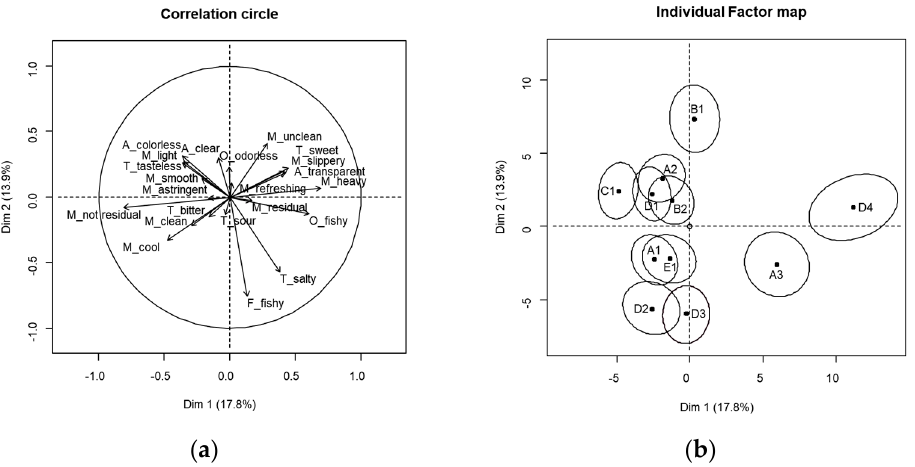
Figure 3. ( a ) Multiple factor analysis of polarized sensory positioning (PSP); ( b ) confidence ellipses of sample configurations of PSP.